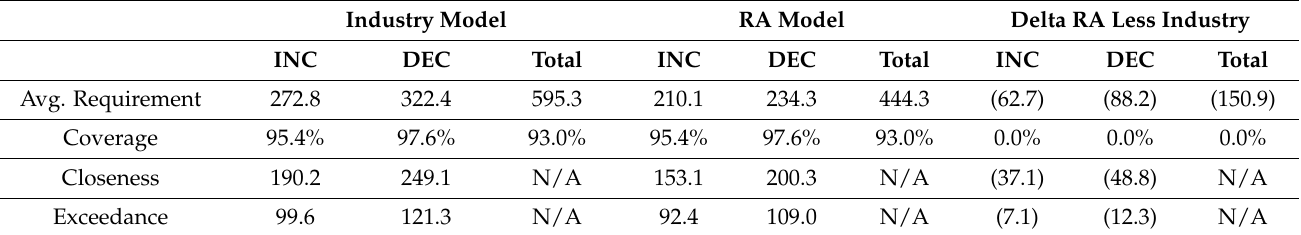
Table 13. Test Results.